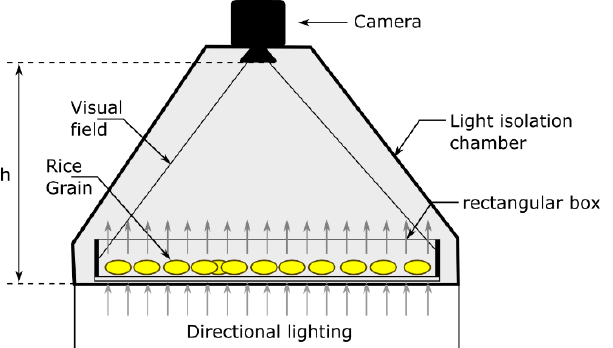
Figure 3. Arrangement of the grains in a structure designed to obtain images.